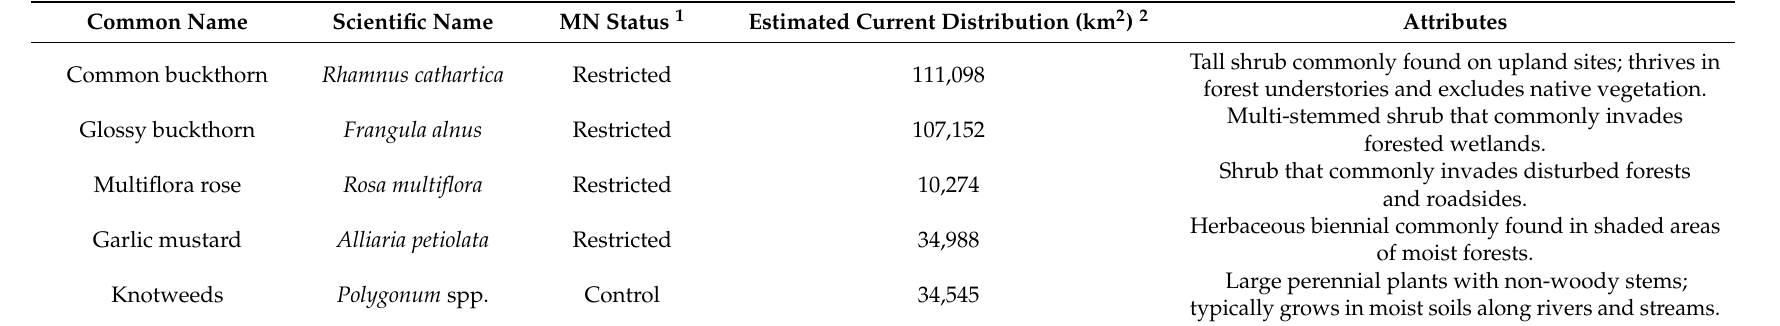
Table 1. Information on invasive plant species included in this